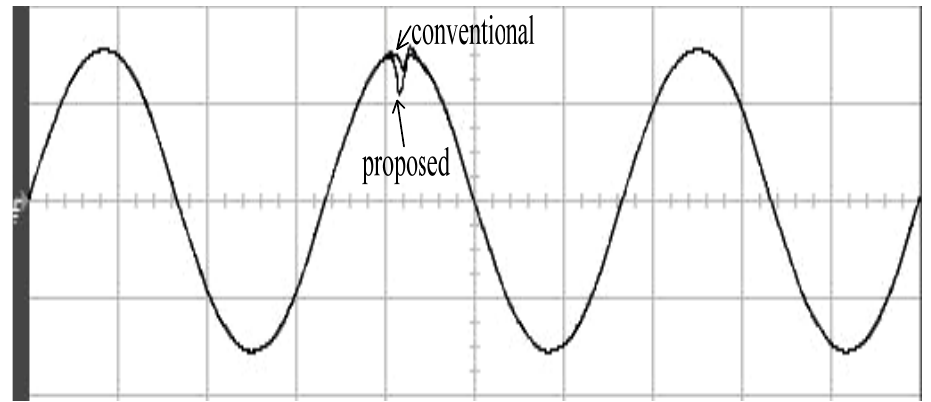
Figure 13. Comparison of experimental output voltage with the proposed controller and the conventional RSMC under step changing in resistive load (vertical: 100 V/div; horizontal: 5 ms/div).